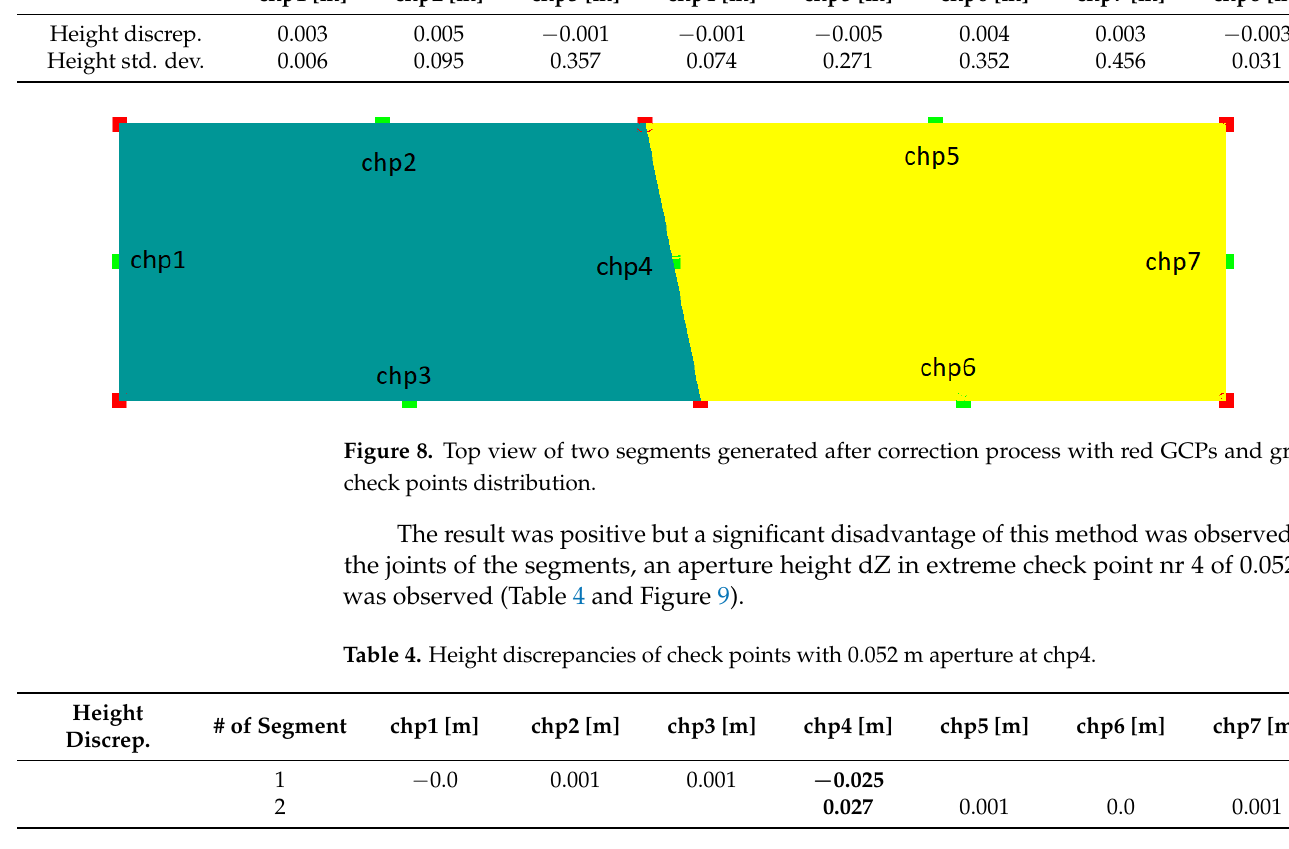
Table 3. Height discrepancies of check points and the standard deviations of the height of the surrounding check point.